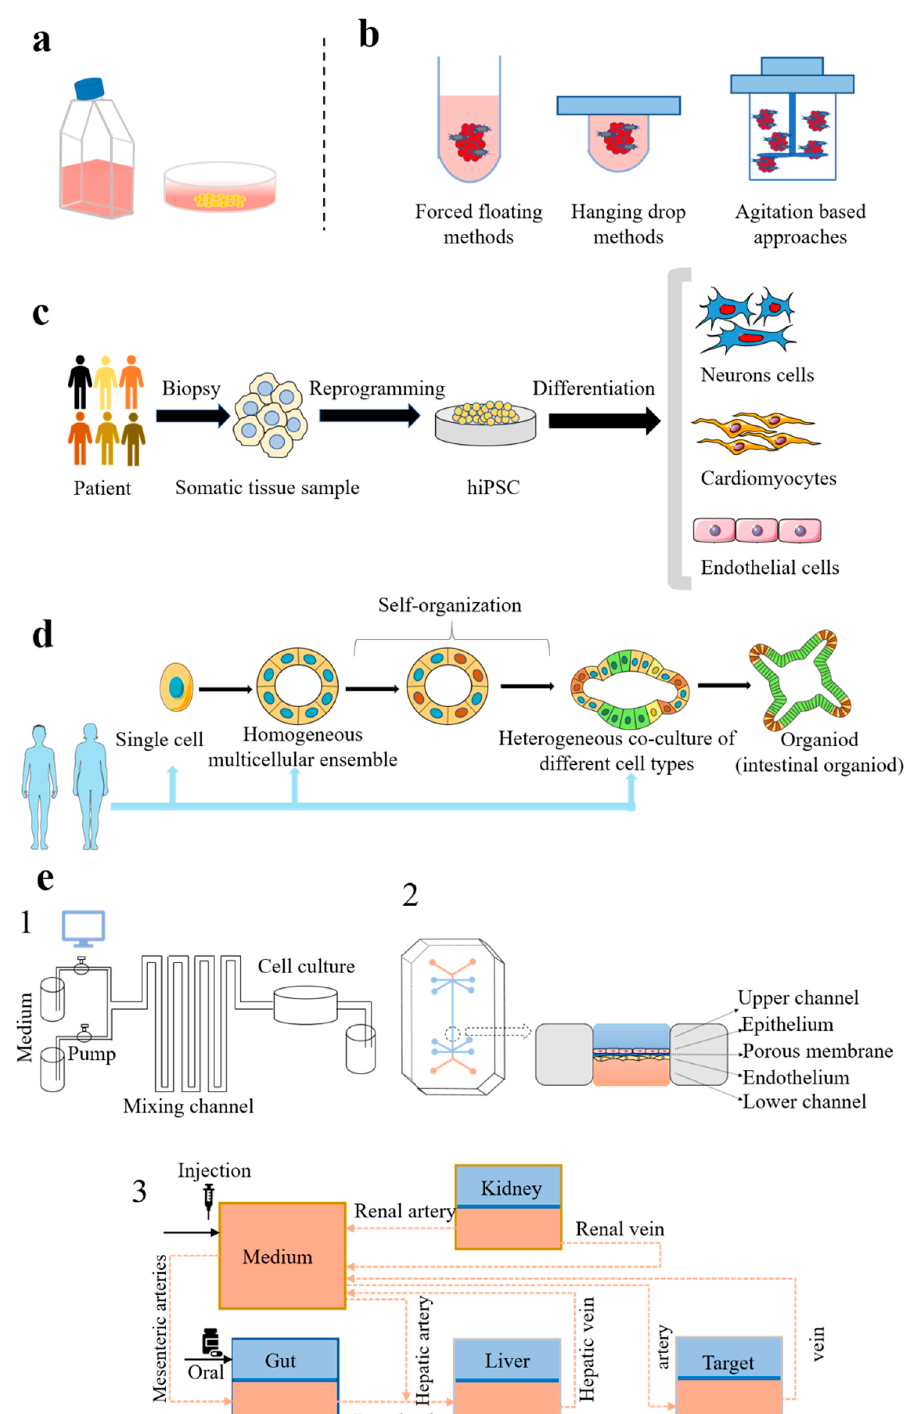
Figure 2. The current various in vitro tools. ( a ) 2D cell culture. ( b ) 3D cell culture. ( c ) hiPSC culture process. Somatic cells are extracted from healthy people or patients and converted into hiPSC through reprogramming. The obtained cells can be differentiated into other cells, such as cardiomyocytes, neurons cells, and endothelial cells. ( d ) Organoid culture process. Organoids can be cultured from human-derived single cell, homogeneous multicellular ensemble, and heterogeneous coculture of different cell types through self-organization. ( e ) Microphysiological systems: (1) controllable and programmable microfluidic cell culture system; (2) structure of organ-on-chips; and (3) integration of or-gan-on-chips, body-on-chips. hiPSC: human-induced pluripotent stem cell.